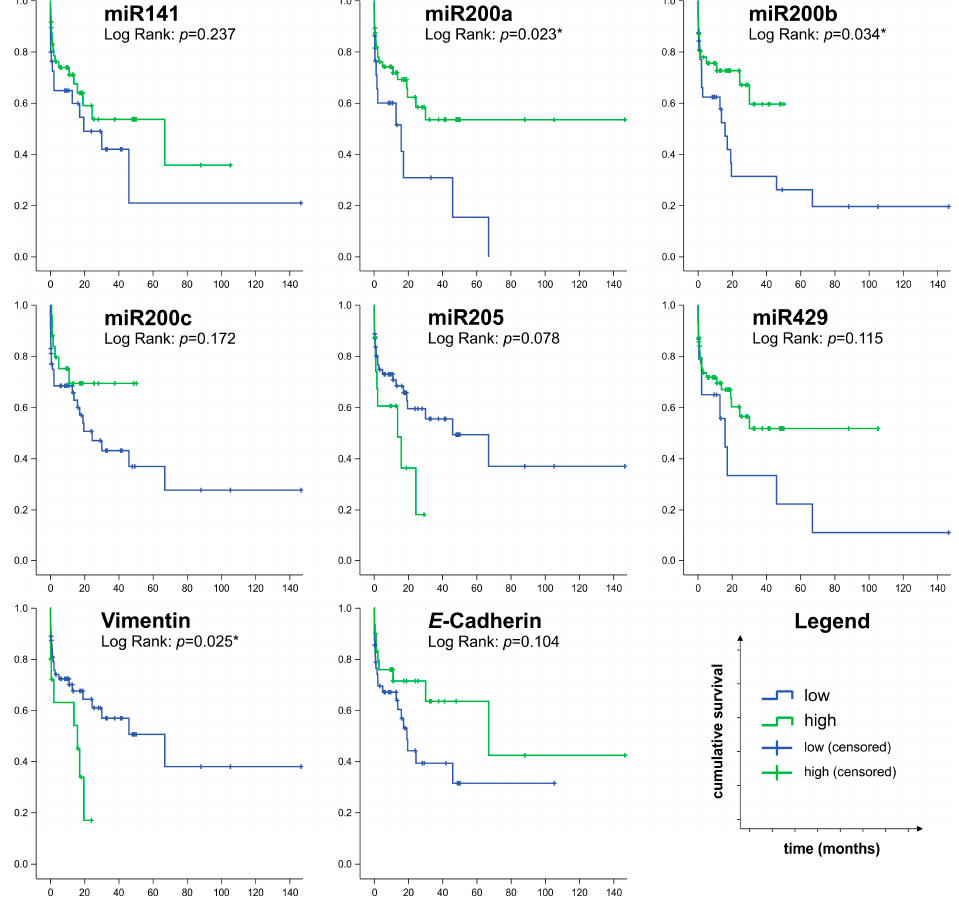
Figure 4. Survival analysis of biliary tract cancer ( n = 78) cases with regard to expression levels of miR200 family members, miR205, E -cadherin and vimentin. The cut-off value for distinguishing cases with low or high expression of the respective miRNA or protein was determined by the receiver operating characteristic (ROC) calculation and Youden Index